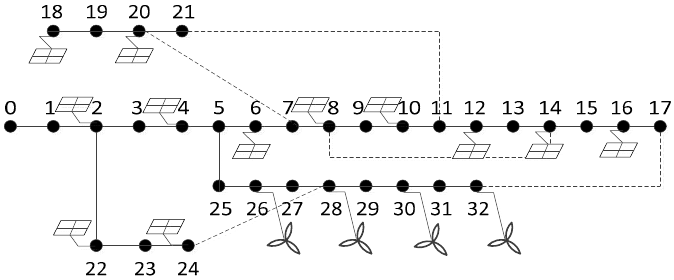
Figure 6. IEEE 33-node power distribution system wiring diagram.